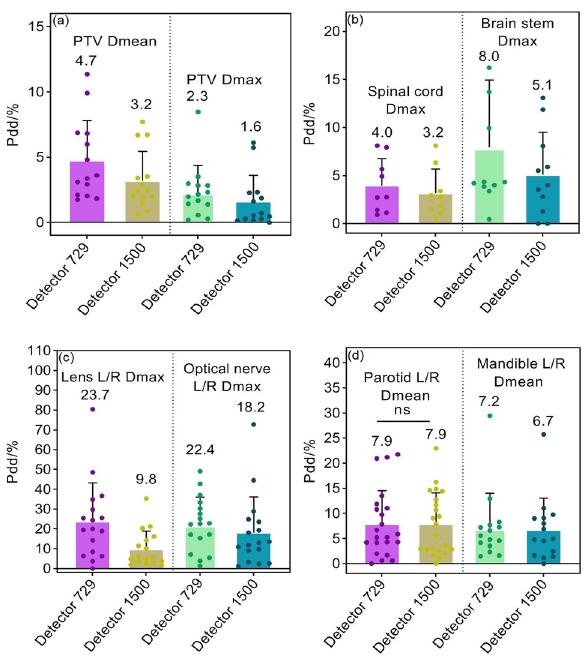
Figure 8. Pdd/% for head and neck radiotherapy plans. ( a ) Percent dose deviations of mean and maximum dose in PTVs; ( b ) Percent dose deviations of maximum dose in spinal cord and brainstem; ( c ) Percent dose deviations of maximum dose in bilateral lens and optic nerves; ( d ) Percent dose deviations of mean dose in bilateral parotid gland and mandible. Pdd/% = Percent dose/volume deviation; ns: p > 0.05.